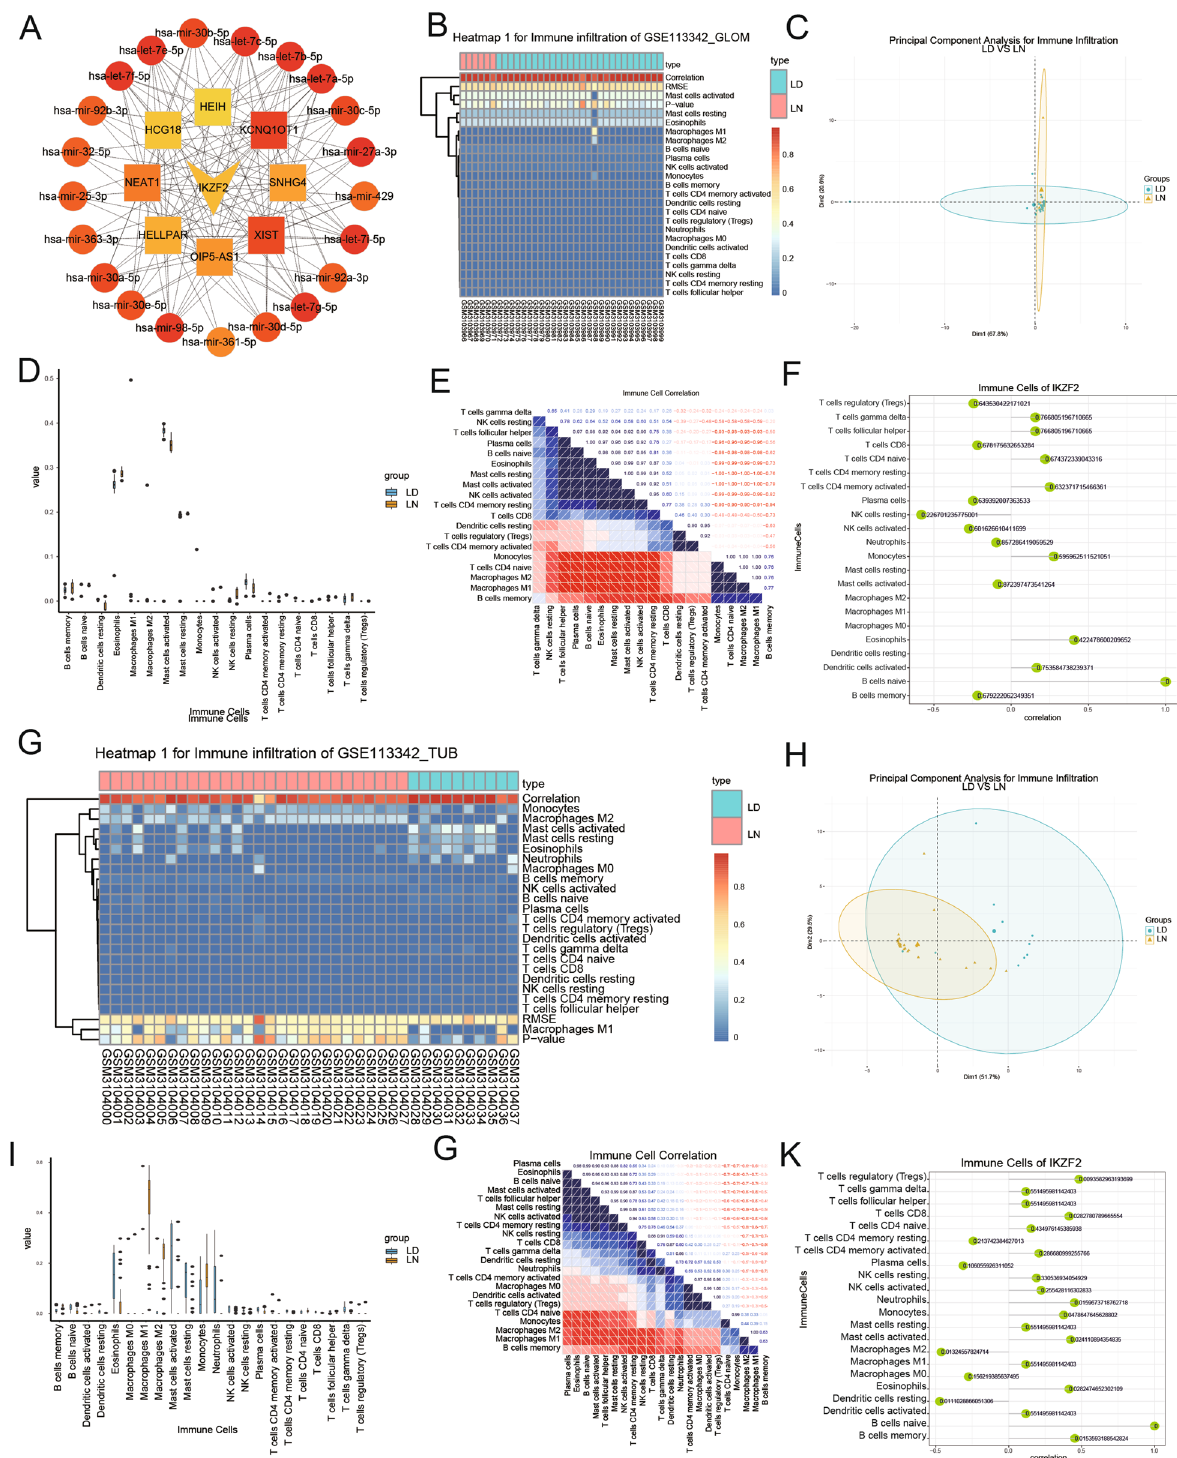
Figure 7. Immune infiltration analysis. ( A ) The cytohub plug-in in cytoscape was utilized for visualizing ceRNA regulatory network including lncRNA-miRNA-mRNA interaction information. ( B )–( E ) Immune infiltration abundance of co-DEGs and the correlation between 22 types of immune cells from GLOM group of GSE11342 dataset. ( F )–( K ) Immune infiltration abundance of co-DEGs and the correlation between 22 types of immune cells from TUB group of GSE11342